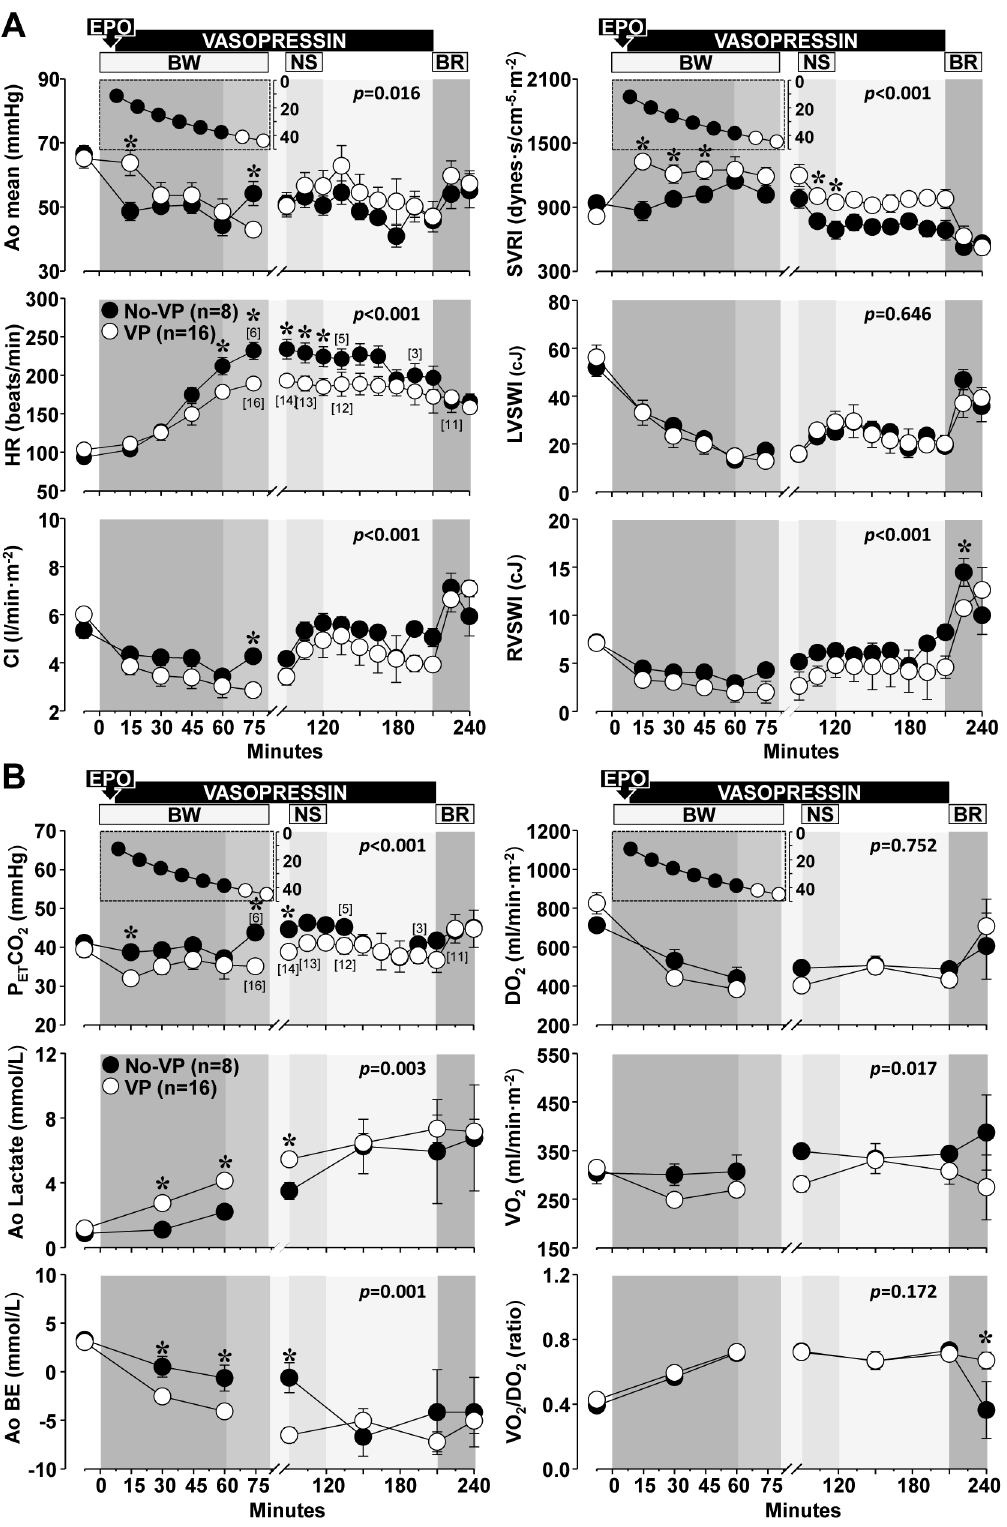
Fig 3. Effects of vasopressin on hemodynamic and metabolic function during hemorrhagic shock. EPO, erythropoietin; BW, blood withdrawal; NS, normal saline; BR, blood reinfusion. The inset depicts the time course of the blood withdrawal (ml/kg) ending at 60 minutes in the 65% BW subset and at 80